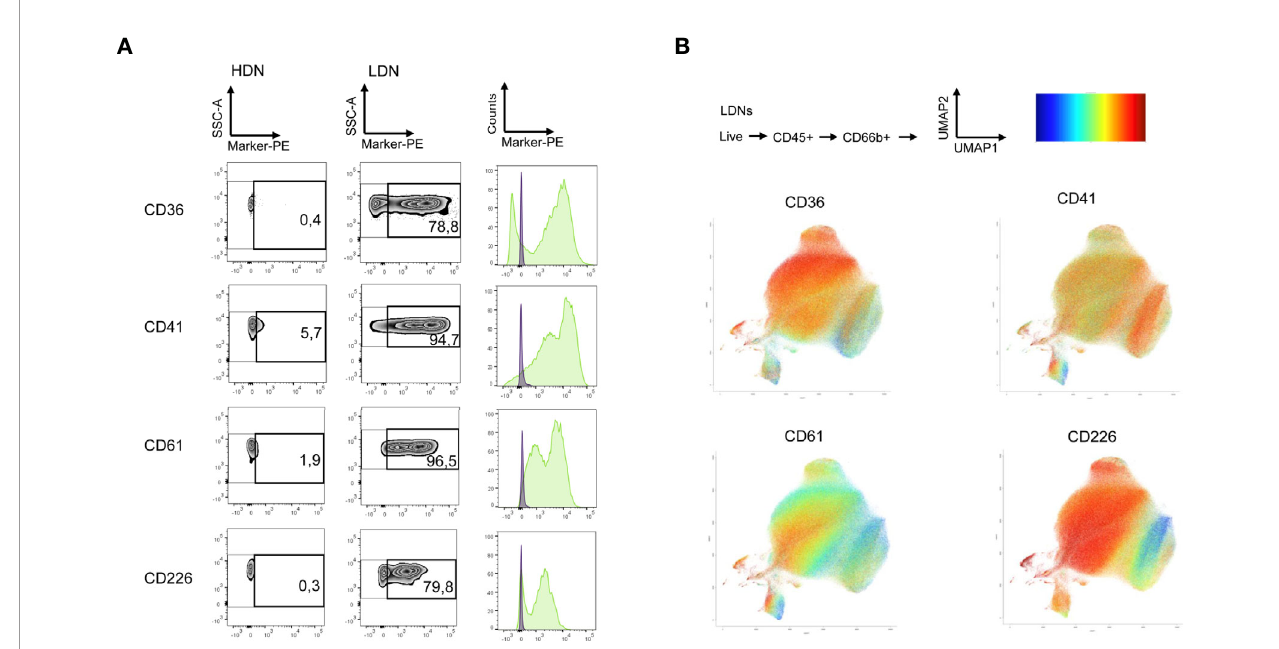
FIGURE 3 | LDNs show heterogenous expression of top screening hits. (A) Selected surface antigens with the most pronounced differences in expression between HDNs and LDNs. Zebra plots representing CD36, CD41, CD61 and CD226, respectively, in the HDN and LDN fractions are presented. Histograms showing the fl uorescence intensity in the HDNs (violet) and LDNs (green) are also displayed. (B) The results of the LegendScreen were used as an input for the In fi nityFlow pipeline. UMAP plots demonstrating heterogeneity of CD36, CD41, CD61 and CD226 expression in LDNs were created based on the predictions of the pipeline expression level high (red), low